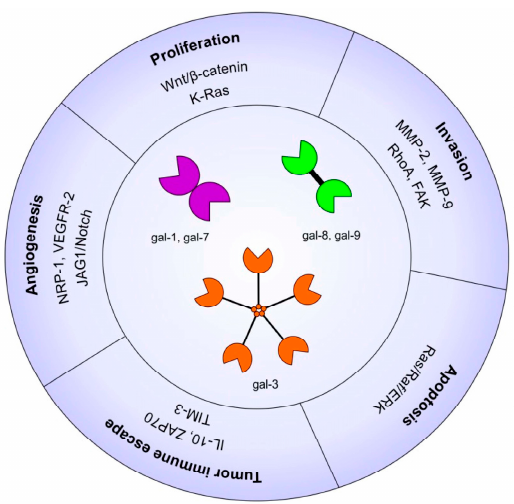
Figure 1. Hallmark of galectins in head and neck cancers. Gal-1, -3, -7, -8, and -9 in cancer progression affecting several pathways including proliferation, apoptosis, invasion, angiogenesis, and tumor-immune escape. Matrix Metalloproteinase (MMP); Interleukin (IL); Focal adhesion kinsase (FAK).